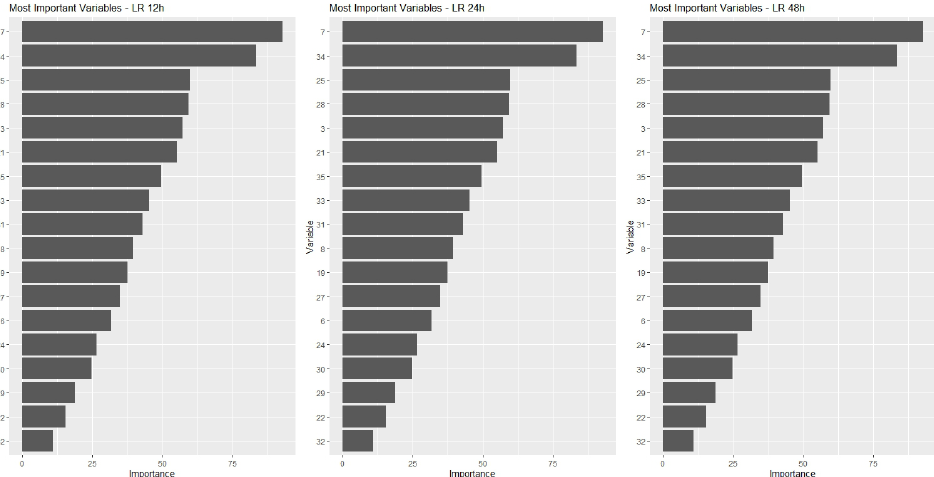
Figure 6. Most Important Variables for LR—Logistic Regression